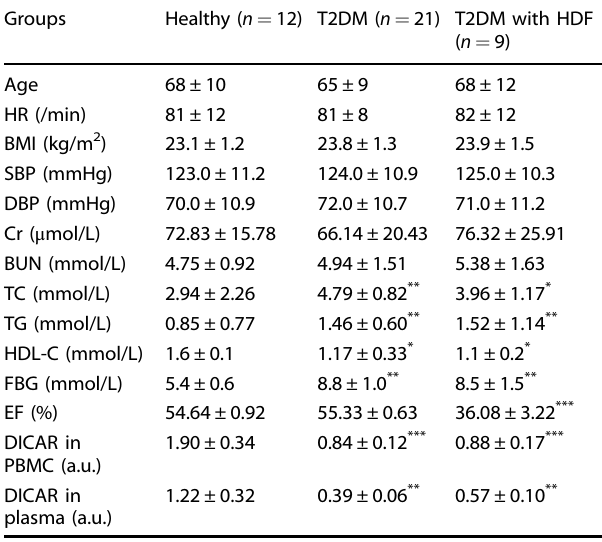
Table 1. Clinical information and DICAR expression in diabetic patients